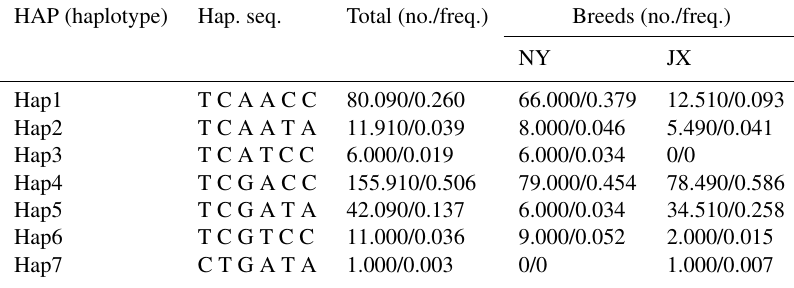
Table 4. Haplotypes and their frequencies of six SNPs in Nanyang cattle and Jiaxian cattle. HAP (haplotype) Hap. seq. Total (no./freq.) Breeds (no./freq.)